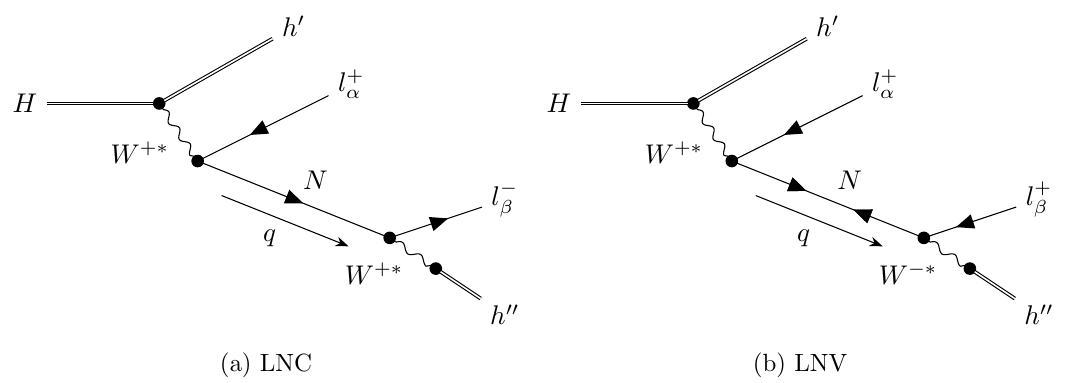
Figure 2. Lepton number conserving and violating decay chains for H ! h